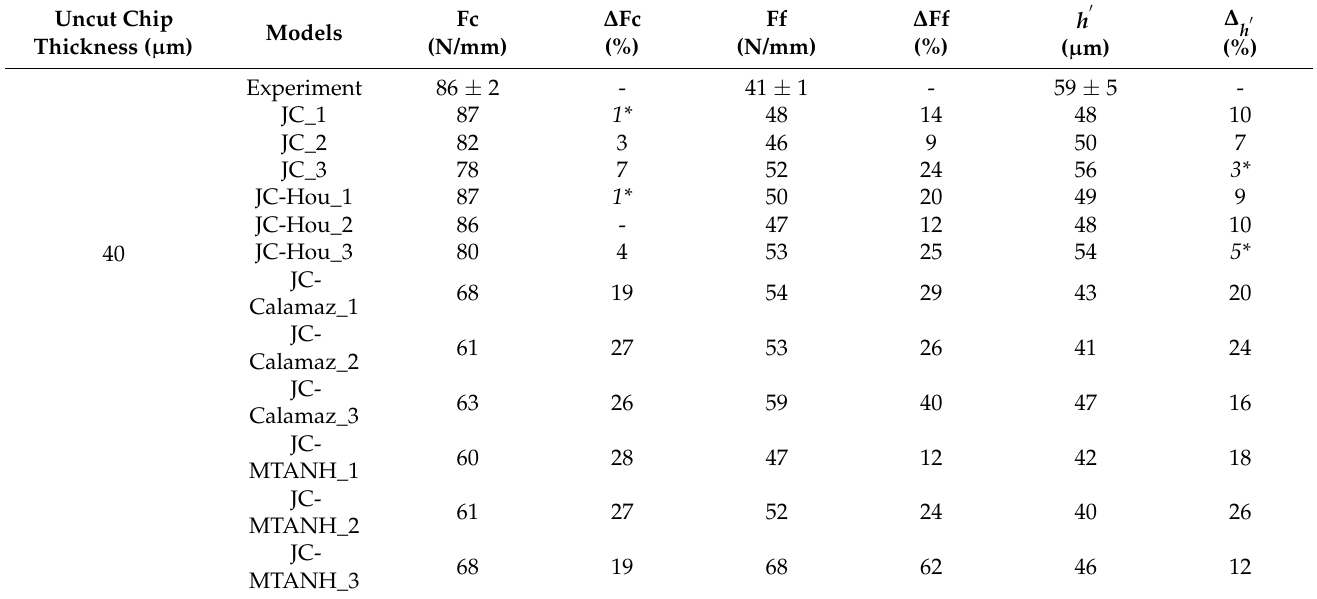
Table 8. RMS cutting force (Fc), feed force (Ff), chip thickness ( h (cid:48) ) and ∆ x differences with the experimental forces of h = 40 µ m. Uncut Chip Thickness ( µ m)